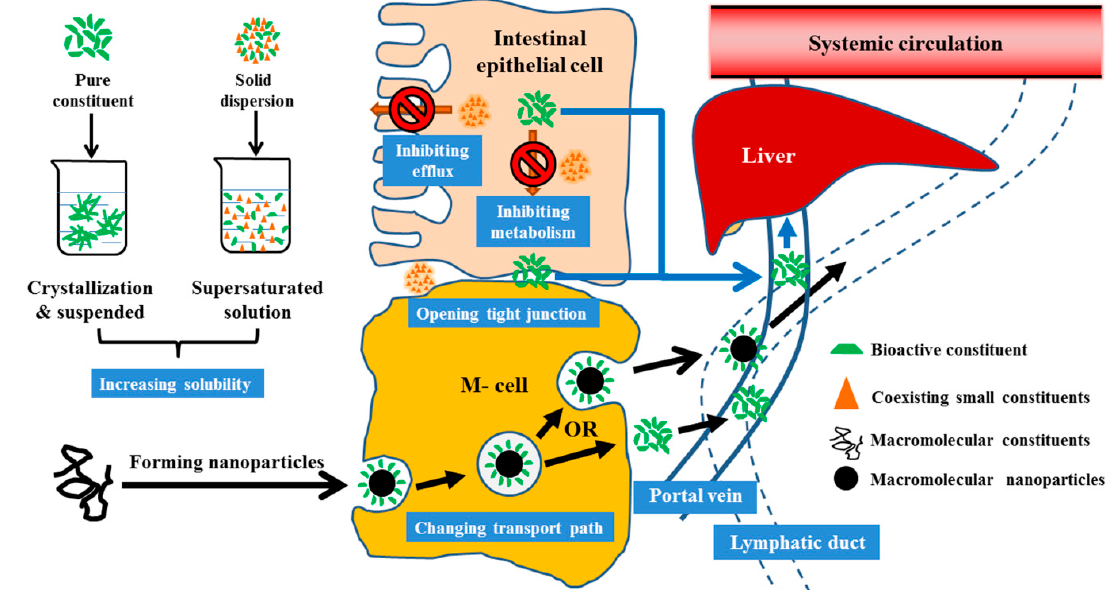
Figure 2. Potential pharmacokinetic synergies among constituents for increasing the intestinal absorption of active constituents in herbal extracts. Coexisting plant-produced compounds including